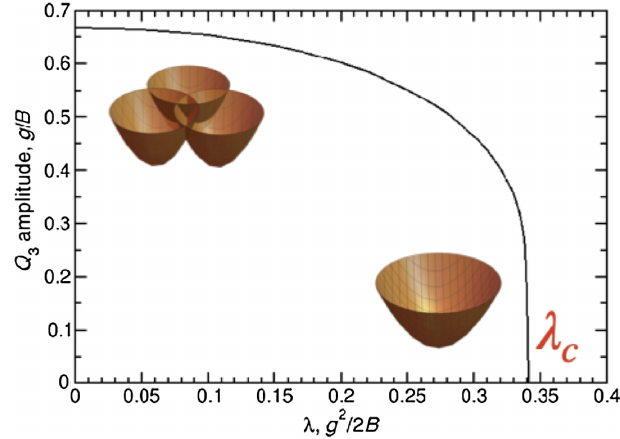
FIG. 4. The amplitude of the Jahn-Teller distortions for t 3 2 FIG. 6. The amplitude of the Jahn-Teller distortions for t 5 2 g configuration as a function of the ratio of the spin-orbit coupling configuration as a function of spin-orbit coupling strength λ . strength λ and Hund ’ s exchange J , the results of the exact Results of the exact diagonalization calculations for g ¼ B ¼ 1 . H 0 . 5 . diagonalization calculations for g ¼ B ¼ 1 and J Insets demonstrate how the total energy surface as a function of H ¼ the Q 2 and Q 3 distortions evolves with λ